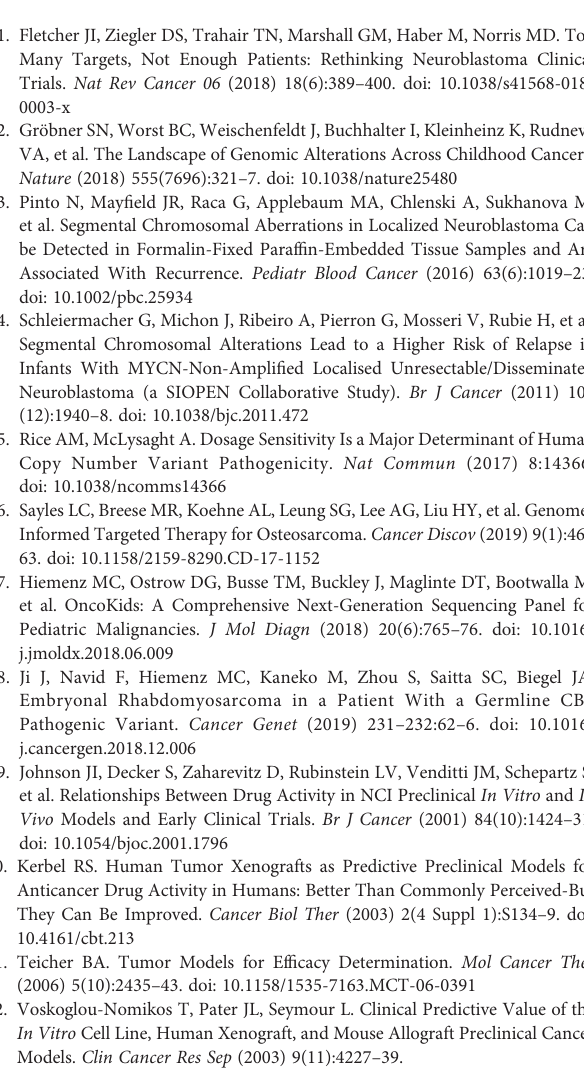
Supplementary Figure S5 | Boxplots showing distribution (median, quartiles, range) of: (top panel) copy number of matched genes, (middle panel) cytotoxicity of matcheddrugs,and(lowerpanel)z-scoresofmatchedgene-drugpairs,veri fi edin6 datasets of gene-drug associations. Supplementary Figure S6 | (A – M) z-score-weighted sub-networks determined by FI-based clustering; corresponding top 5 signaling pathways most enriched in the sub-networks are listed. Source of pathways are annotated as follows: (C) CellMap, (R) Reactome, (K) KEGG, (N) NCI PID, (P) Panther, (B) BioCarta. Supplementary Data Sheet 1 | Genomic pro fi ling, drug screening and Pearson correlation data. Supplementary Data Sheet 2 | Reactome and GO annotations. Supplementary Data Sheet 3 | Neuroblastoma PDC and tumor STR pro fi les. Supplementary Data Sheet 4 | Neuroblastoma PDC growth